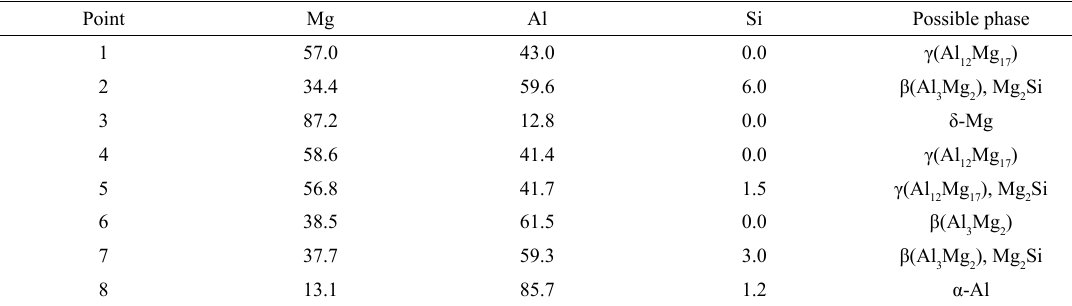
Figure 8. SEM images and EDS local point scanning composition analysis on the interfacial transition zone of Mg/Al composite plate under different conditions: (a) as-rolled, (b) annealed at 400 ºC for 180 min. Table 4. Point scanning results and possible phase present in interfacial transition zone of Mg/Al composite plate (mass